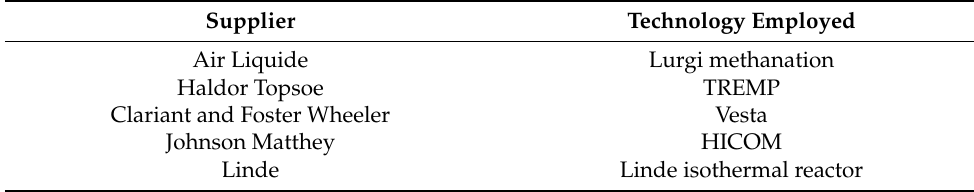
Table 3. Top methanation producers worldwide.